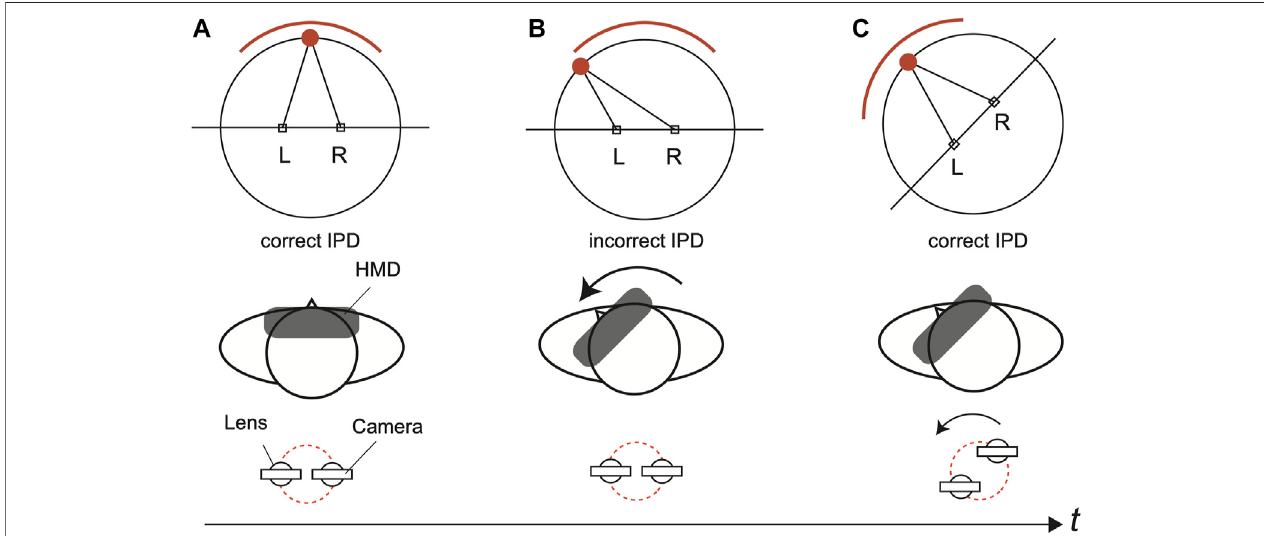
FIGURE 6 | IPD change in the TeleParallax system. The cameras provide a stereo image with the correct IPD (A) . When head motion occurs, the viewer sees anotherstereoimagewithoutblurringthankstothepanoramas,buttheIPDisincorrect (B) .ThestereoimageisslowlyupdatedtoonewiththecorrectIPD (C) .Notethat the midpoint between the observer ’ s eyes lies off the axis of